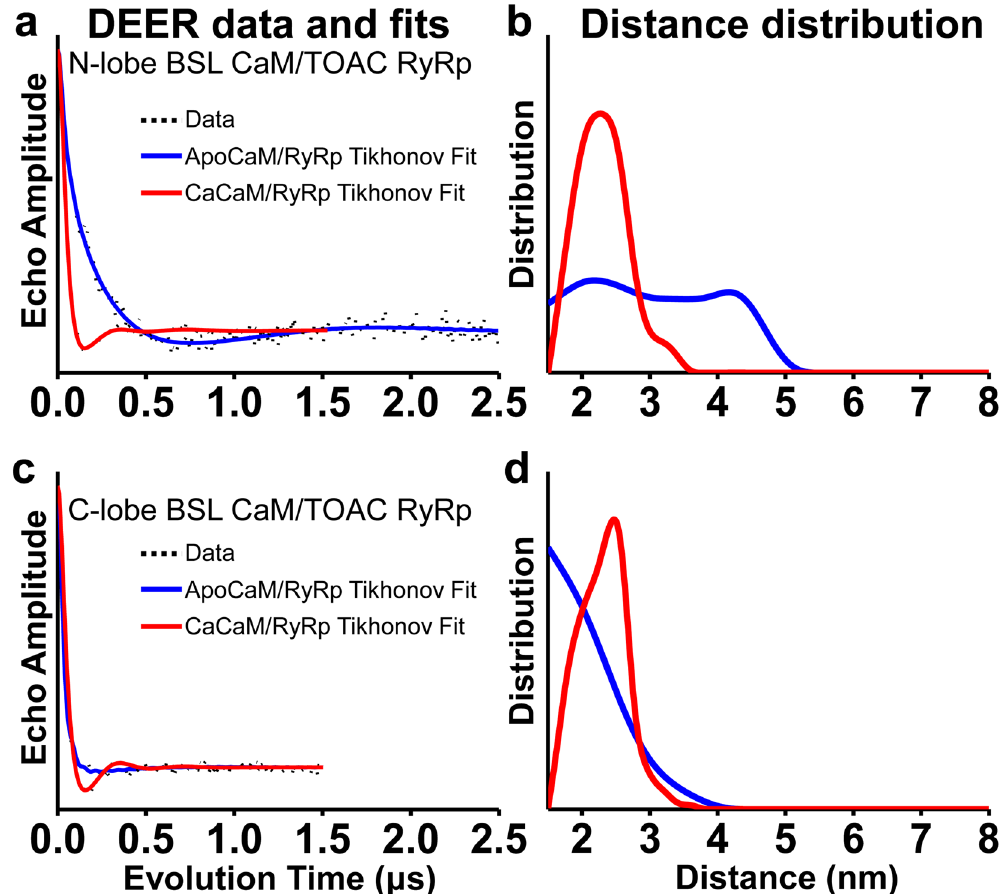
Figure 4. Intermolecular (between CaM and RyRp) DEER distance measurements resolving the Ca-dependent structural states of the CaM/RyRp complex, in the absence of Ca (blue, apo, Fig. 1f) or presence of saturating Ca (red, Ca, Fig. 1e). Distance measurements were made between 5-TOAC-RyRp and N-lobe BSL-CaM ( a,b ), and 5-TOAC-RyRp and C-lobe BSL-CaM ( c,d